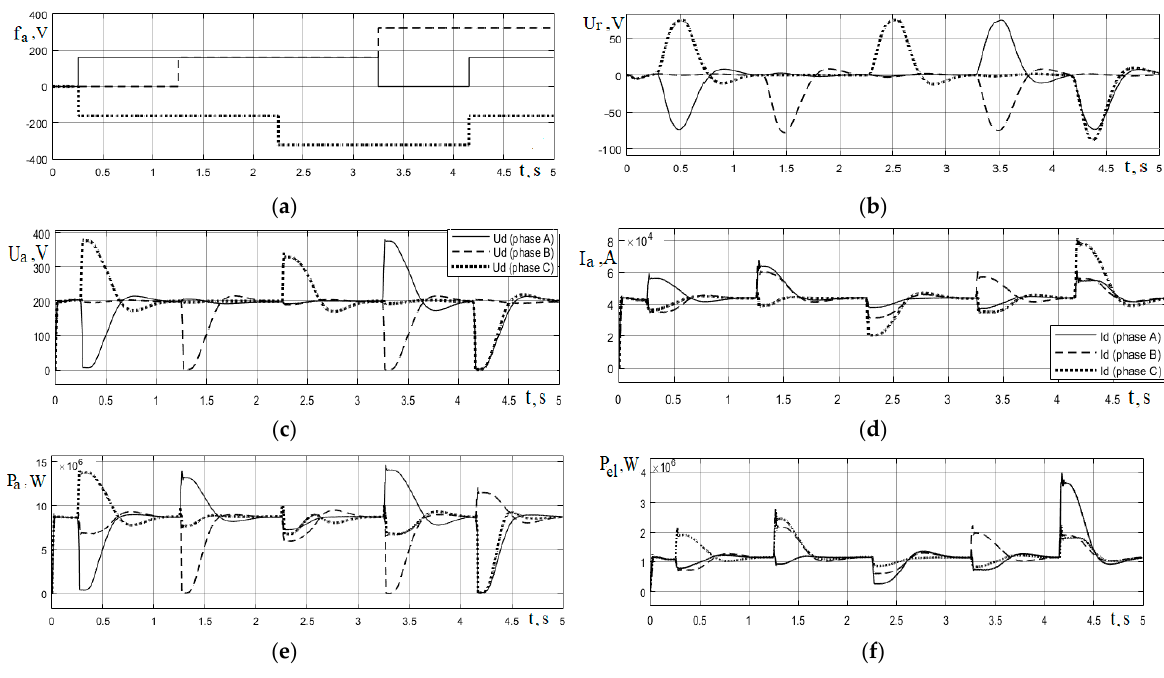
Figure 6. Time dependences of deterministic perturbations for each three phases: ( a ) mismatch signals; ( b , c ) voltages; ( d ) currents; ( e ) power of arcs; ( f ) power of electric losses—when using fuzzy model (6).